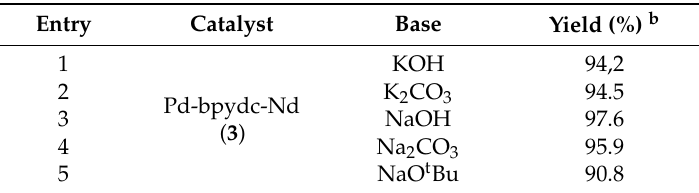
Table 4. Suzuki–Miyaura cross-coupling of 4-bromobenzonitrile with phenylboronic acid in the presence of Pd-bpydc-Nd ( 3 ) when various bases are used a .